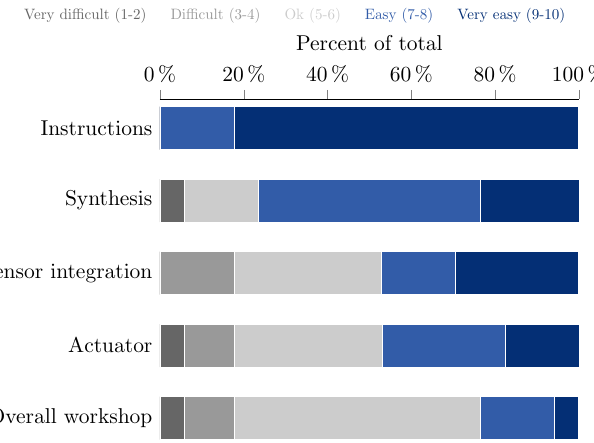
Figure 8. Difficulty analysis of the instructions, the workshop and its parts. The data is obtained from the